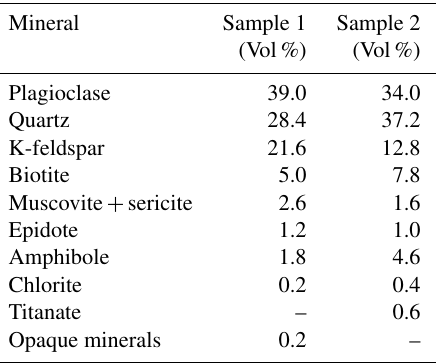
Table 3. Mineralogical composition of the Grimsel granodiorite (Gr-Gr) (After Jokelainen et al., 2013).